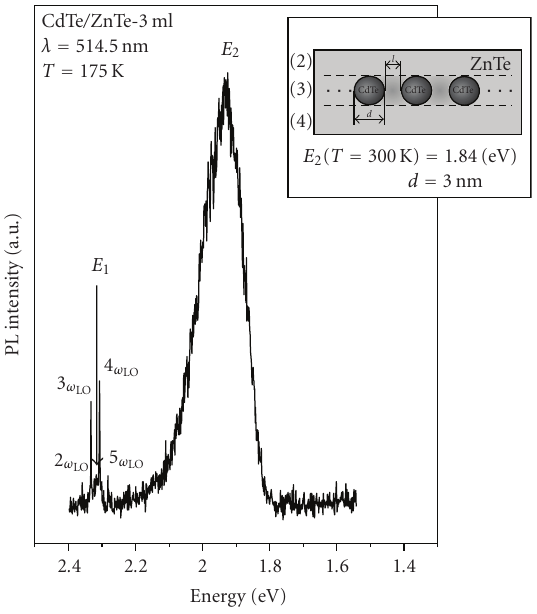
Figure 2: Typical PL spectra of sample with 3ml of CdTe in the finishing layer; PL spectra are excited by λ = 514.5 nm Ar-laser line and recorded at 175 K. Insert: schematic presentation of the structure of